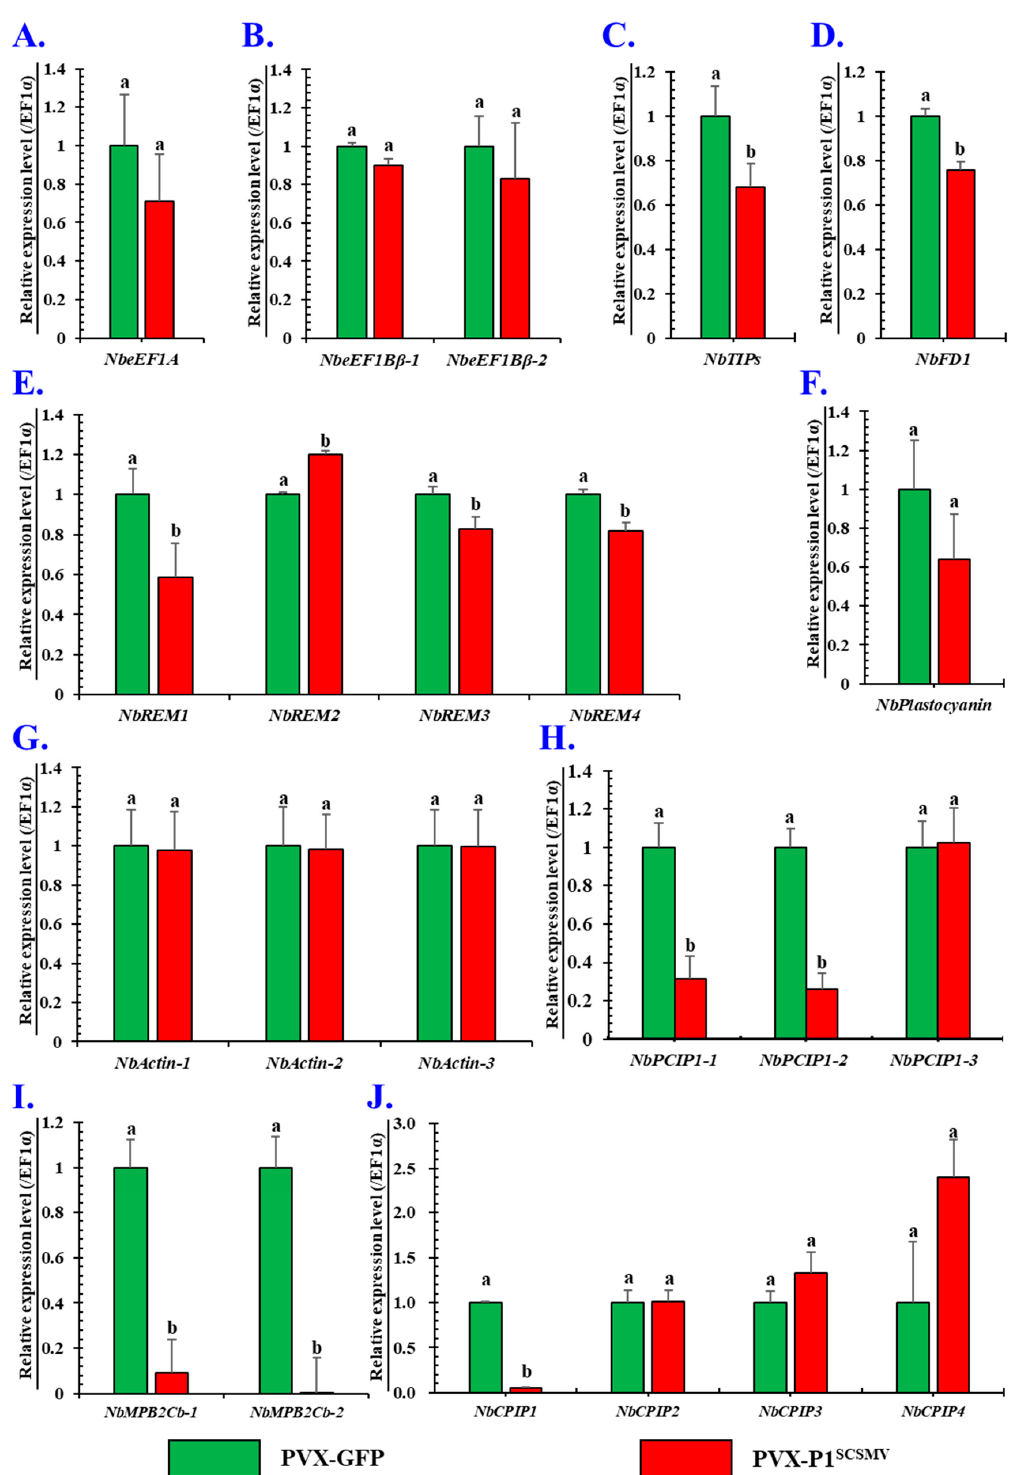
Figure 7. Relative expression levels of genes for ten candidate host factors that direct interactions with PVX-encoded proteins, as evaluated by qRT-PCR. Ten candidate genes, including NbeEF1A ( A ), F1B β s ( B ), NbTIPs ( C ), NbFD1 ( D ), NbREMs ( E ), NbPlastocyanin ( F ), NbActins ( G ), NbPCIP1s ( H ), NbMPB2Cbs ( I ), and NbCPIPs ( J ) interacted with the PVX-encoded proteins directly. The green columns refer to the PVX-GFP-infected plants, while red columns stand for the PVX-P1 SCSMV -infected plants. The SPSS software was used for statistical analysis. Different letters (a & b) mean significant difference between these two